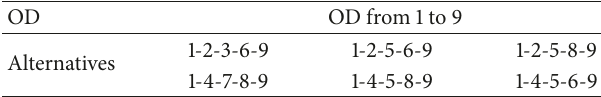
Table 1: OD in the network and the alternative routes. OD